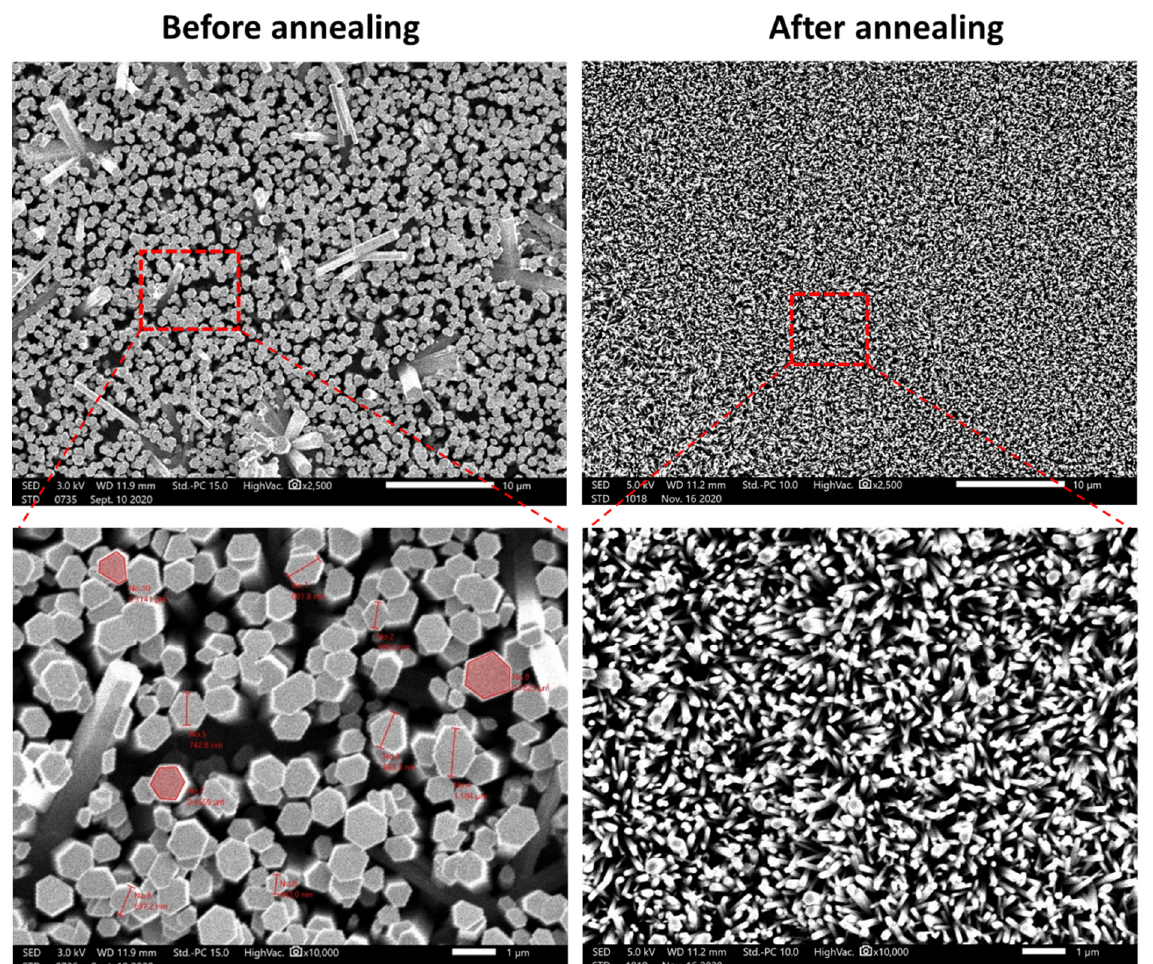
Figure 4. SEM images revealing the effect of annealing temperature on the diameter of ZnO nano- rods.